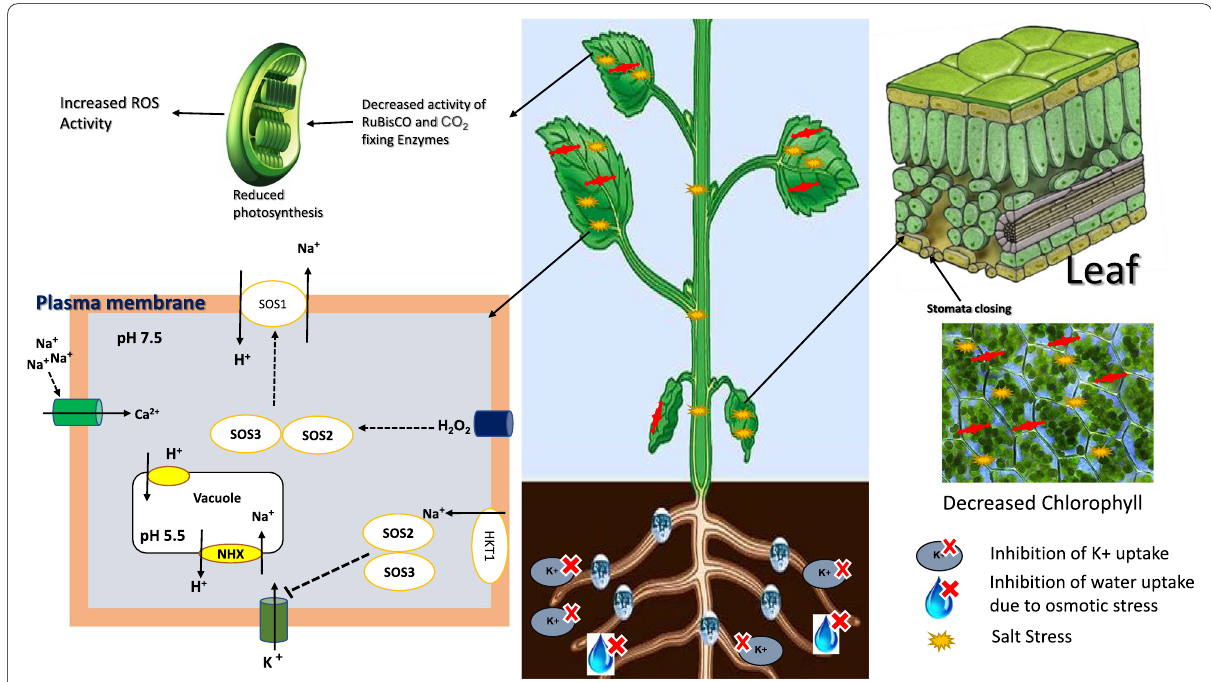
Fig. 1 Dissecting mechanisms of salinity tolerance in